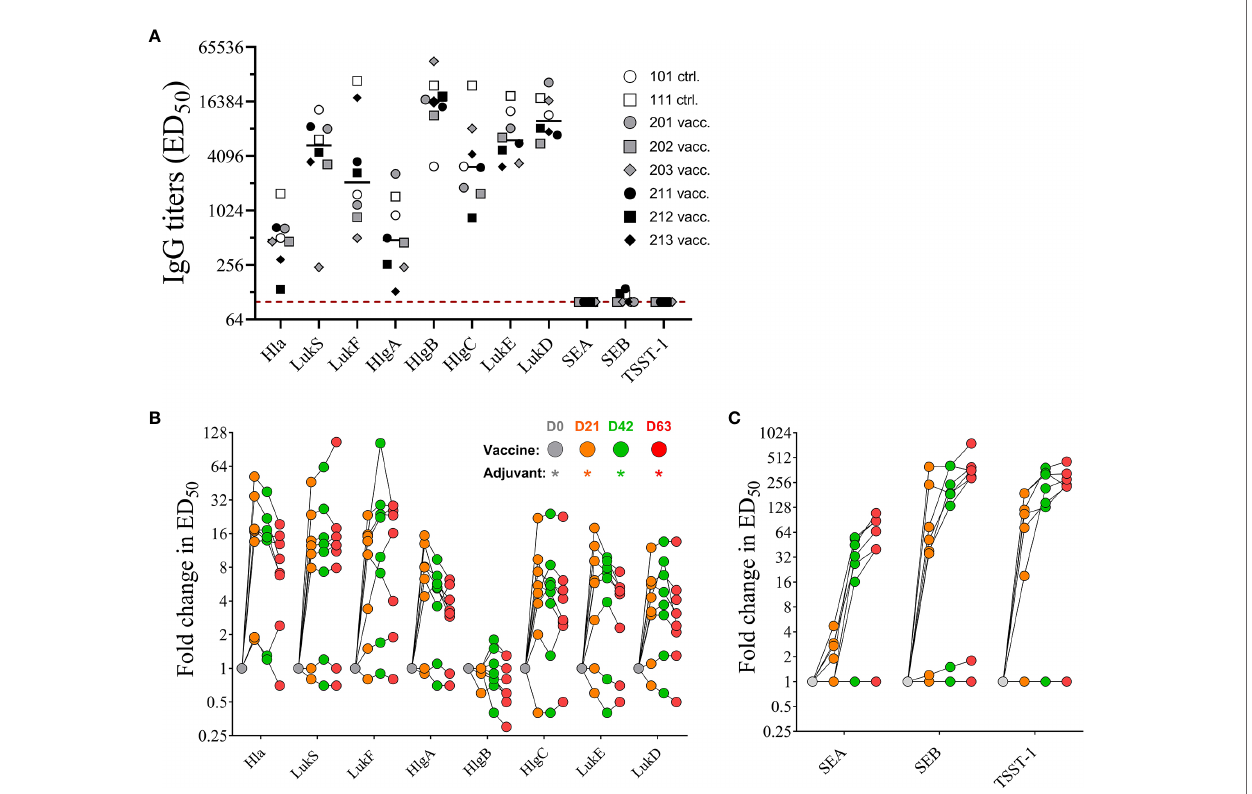
FIGURE 5 | Serum IgG titers. Pre-existing serum titers against staphylococcal antigens in sera of non-human primates (NHPs) prior to vaccination. NHPs receiving 4-component vaccine (vacc.) and NHPs receiving adjuvant only (ctrl.) Dotted lines indicate limit of detection set at 100, the lowest serum dilution tested in the assay (A) . Fold increase of IgG titers of NHP sera collected on days 0, 21, 42, and 63 toward wildtype pore-forming toxin Hla, PVL subunits LukS and LukF, HlgAB/CB subunits HlgA, -B, and – C, and LukED subunits LukE and LukD (B) and superantigens SEA, SEB, and TSST-1 (C) . Data was analyzed with GraphPad PRISM